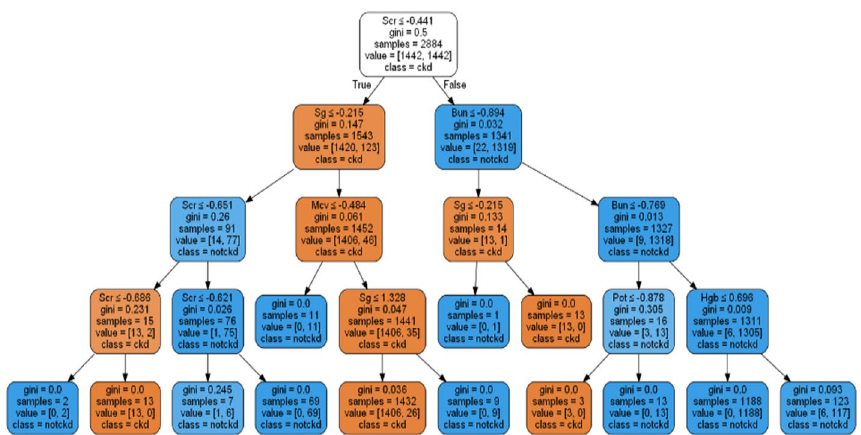
Fig. 5 Decision making in binary class of chronic kidney disease